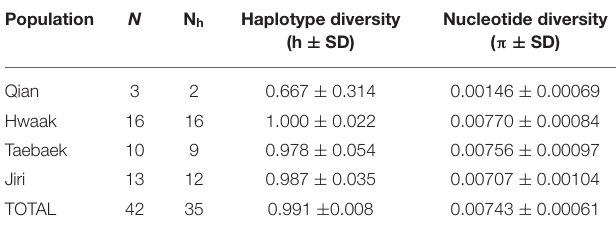
TABLE 1 | Population genetics summary statistics for populations of Bufo stejnegeri designated based on mountain range, based on a concatenated ND2 - ND3